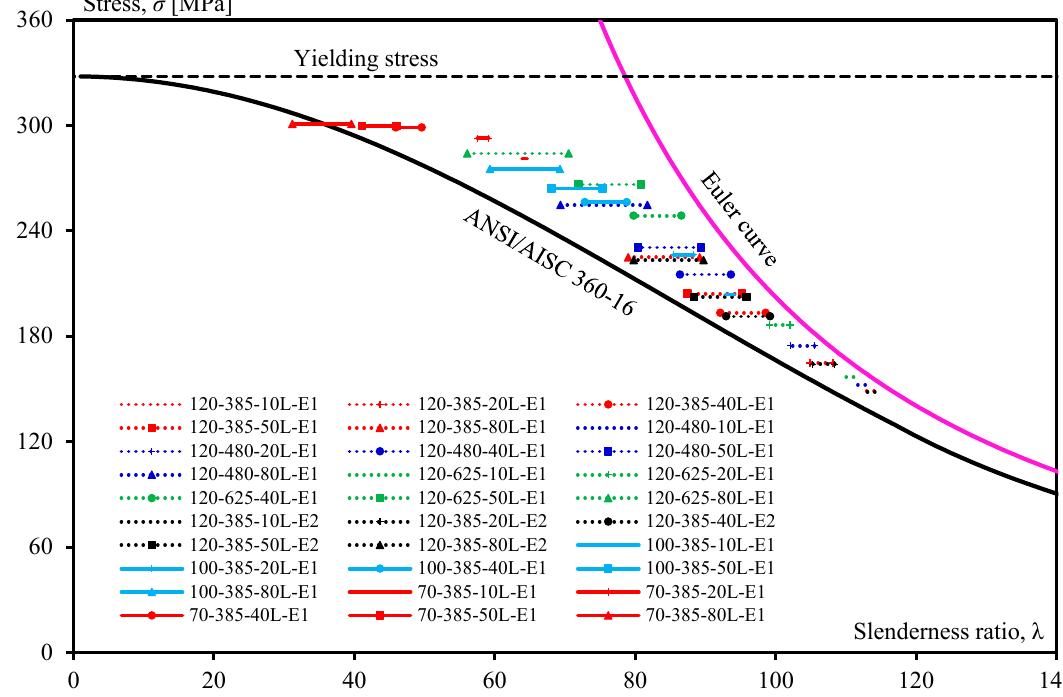
Figure 15. Compressive stress of strengthened steel members plotted based on an equivalent slenderness ratio.